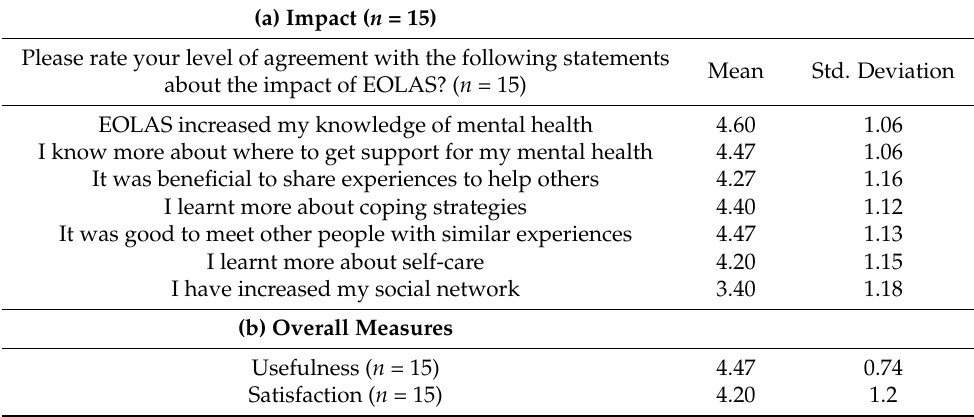
Table 3. Impact, Usefulness,